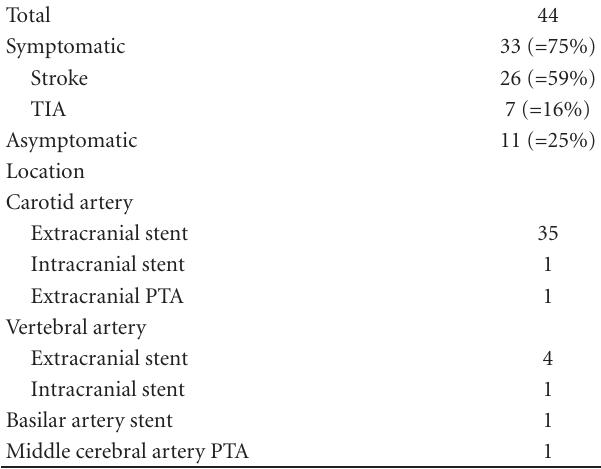
Table 1: Vessels that underwent